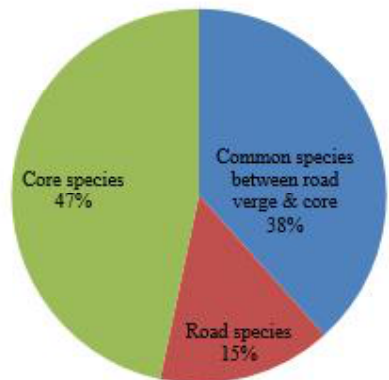
Fig. 2: Distribution of insect species found at the study